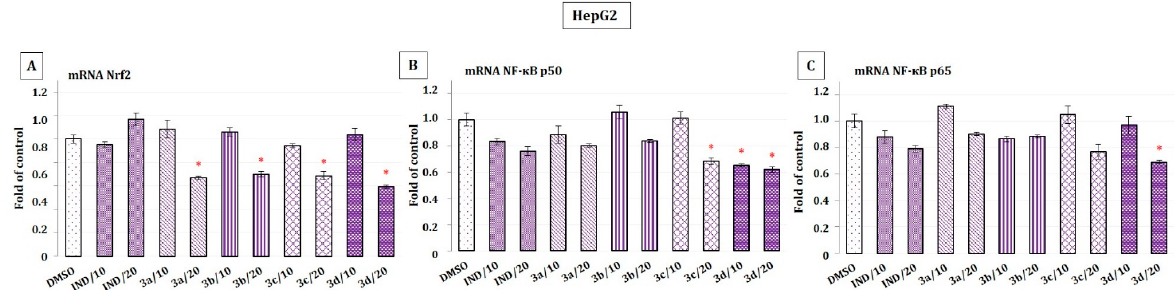
Figure 7. The effects of IND and OAO–IND derivatives ( 3a, 3b, 3c, and 3d ) on the Nrf2 ( panel A ) and NF- κ B subunits’ ( panels B , C ) transcript levels in HepG2 cells. The values (means ± SEM) for the mRNA in HepG2 cells were calculated from three separate experiments in comparison with control cells (expression equals 1). * Significantly different from DMSO (control)-treated cells, p < 0.05.